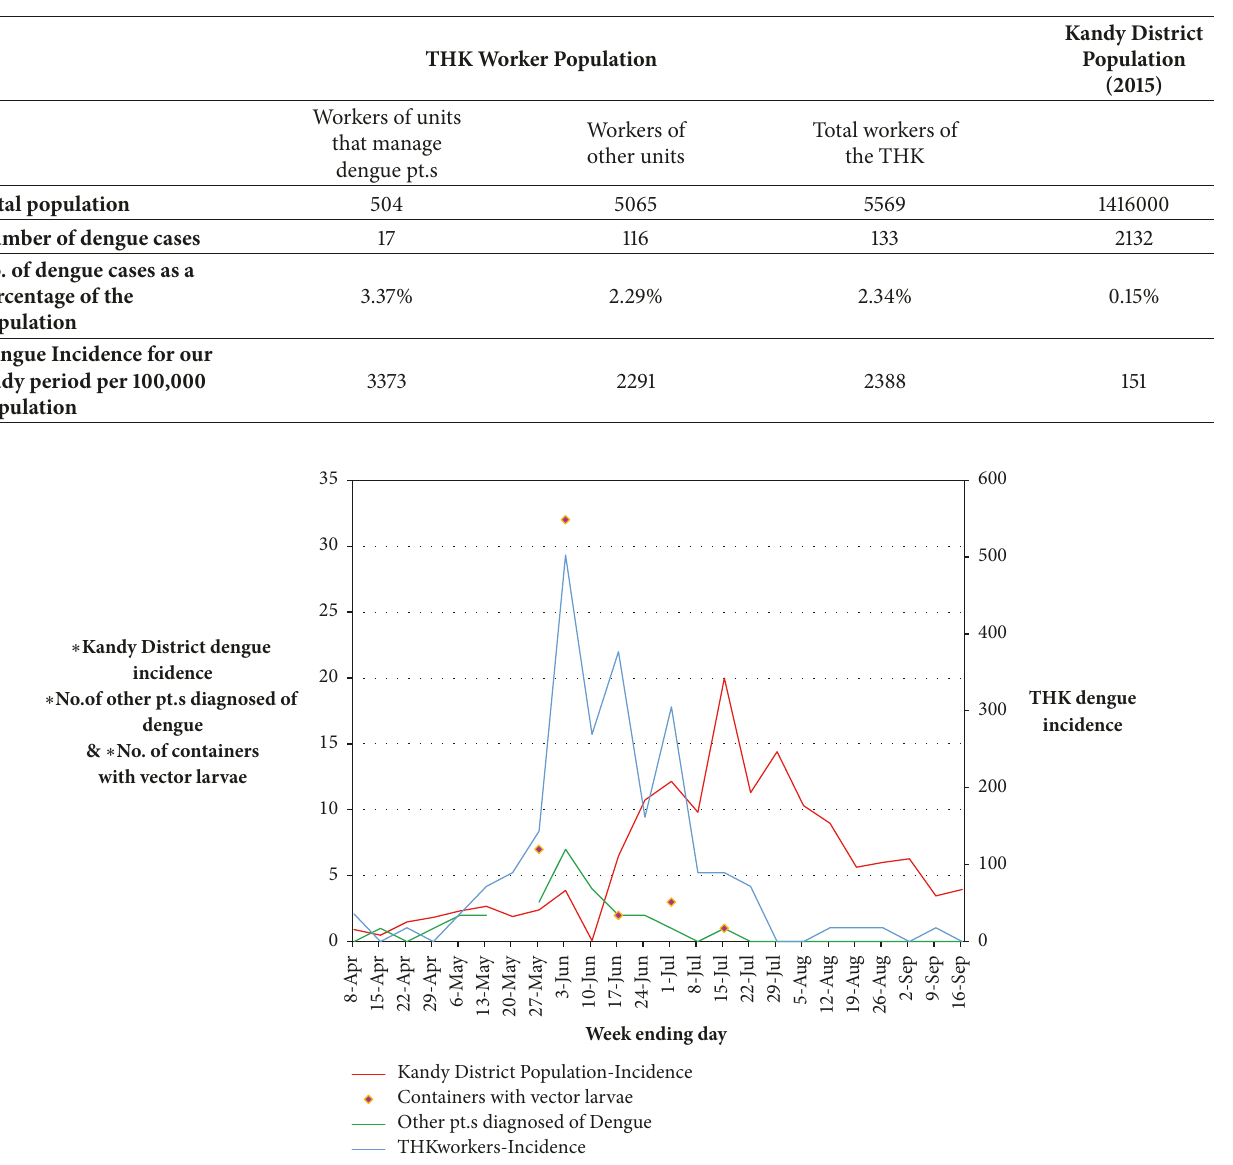
Table 1: The comparison of THK worker and Kandy district populations.